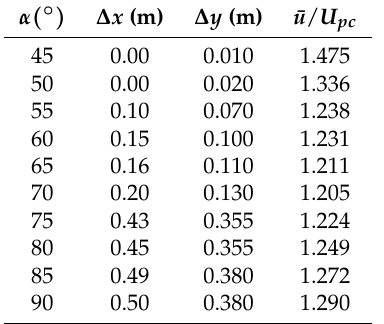
Table 2. Non-dimensional maximum streamwise velocity component at different junction angles. α ( ◦ ) ∆ x (m) ∆ y